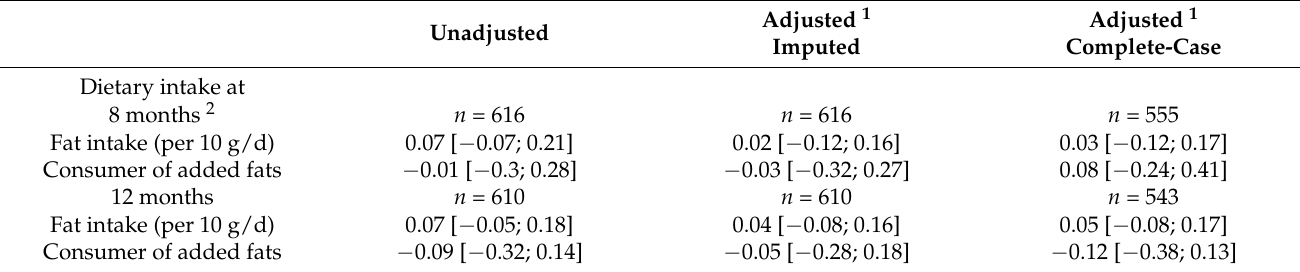
Table 4. Associations ( β (CI 95%)) between infant dietary intakes and their liking for fattiness scores in young children.